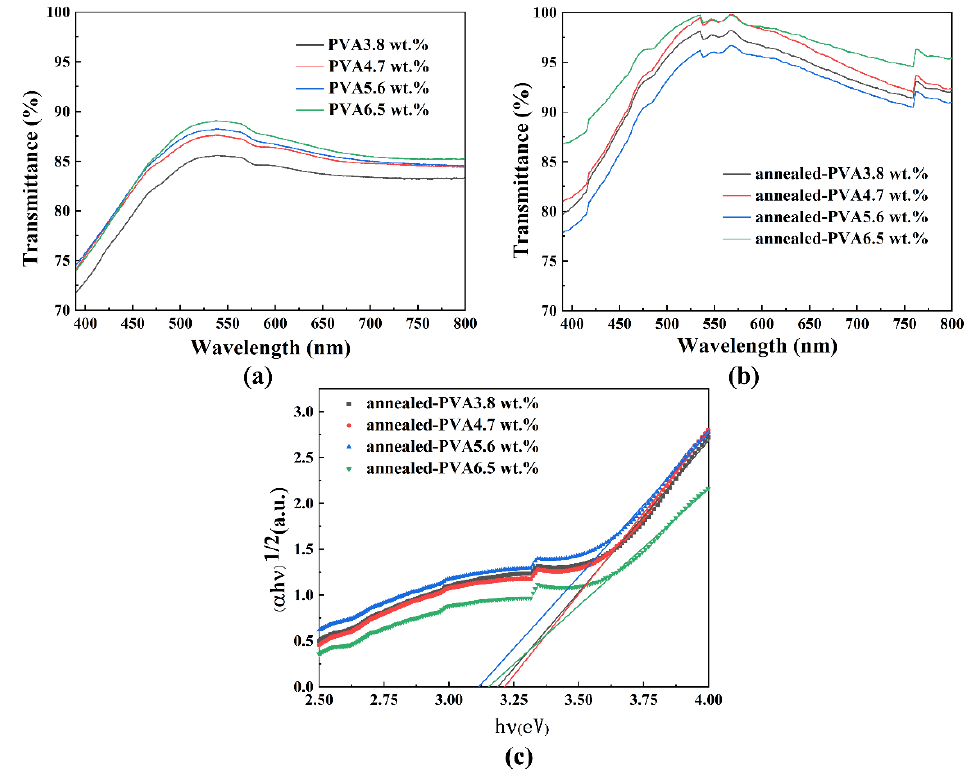
Figure 7. Transmittance of films: ( a ) screen printing PVA + FSO ink formulas without annealing process, ( b ) screen printing PVA + FSO ink formulas with annealing process, ( c ) optical bandgap energy of annealed films using the ink formulas.